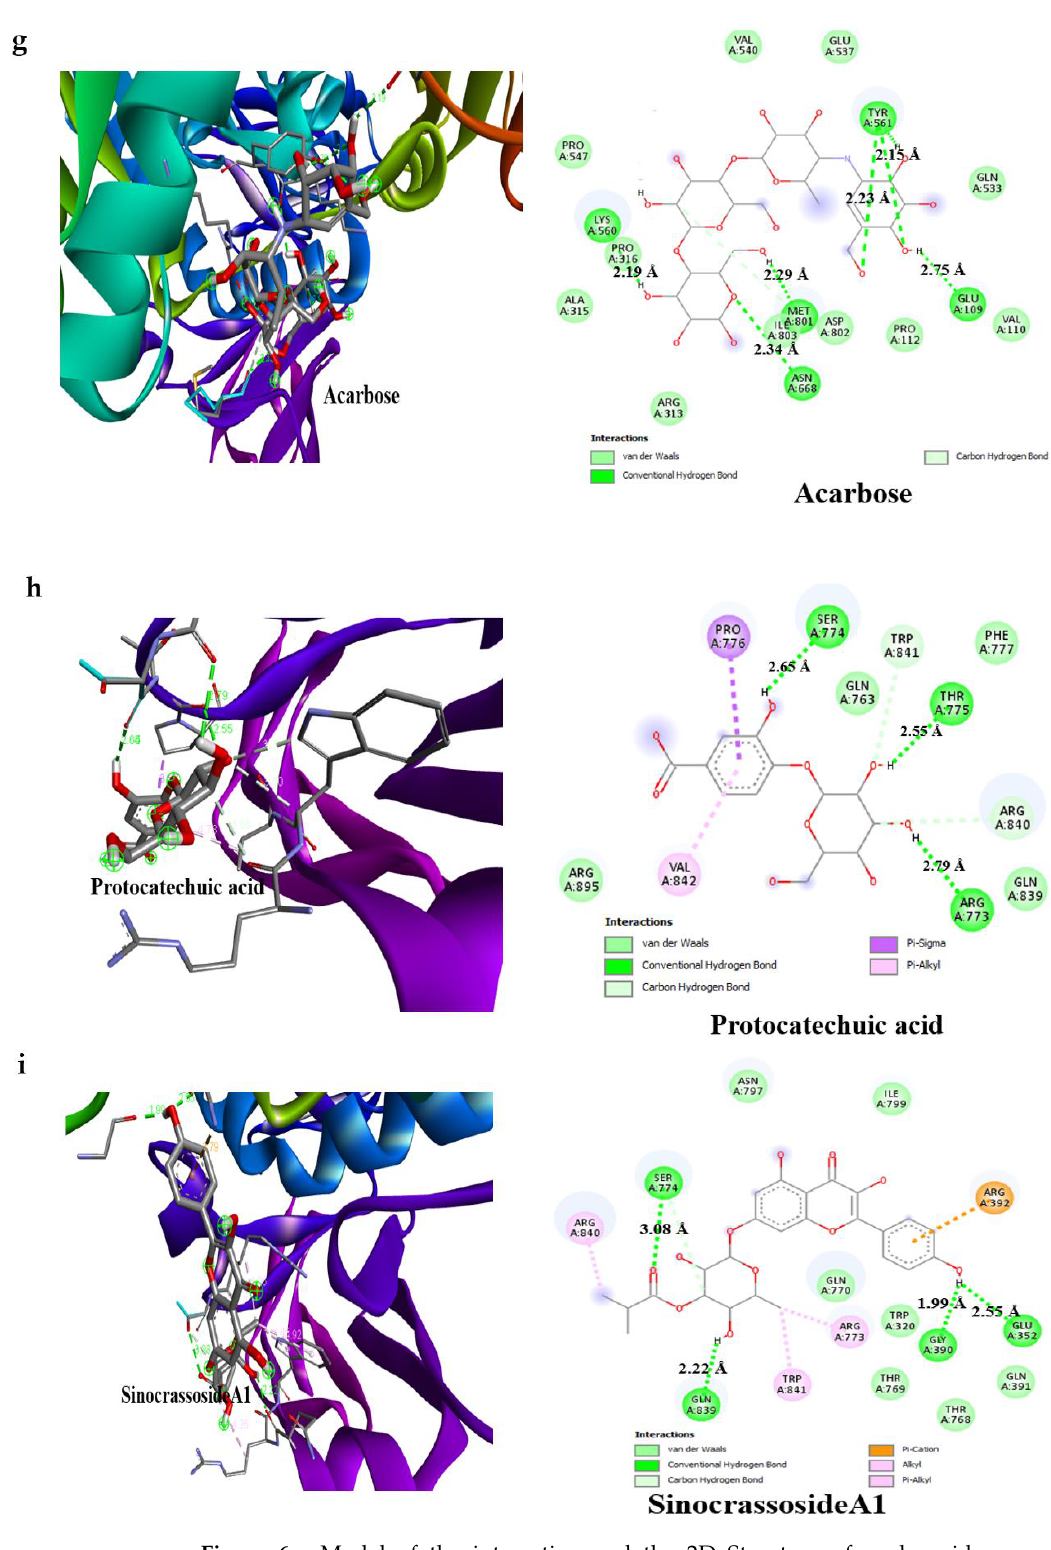
Figure 6. Model of the interaction and the 2D Structure of α-glucosidase protein with ( a ) 3-caffeoylquinic acid, ( b ) 3- O - Caffeoyl-4- O -methylquinic acid, ( c ) 4-Feruloylquinic acid, ( d ) 5-Feruloylquinic acid, ( e ) Arbutin, ( f ) Engeletin, ( g ) Acar- bose ( h ), Protocatechuic acid, and ( i )